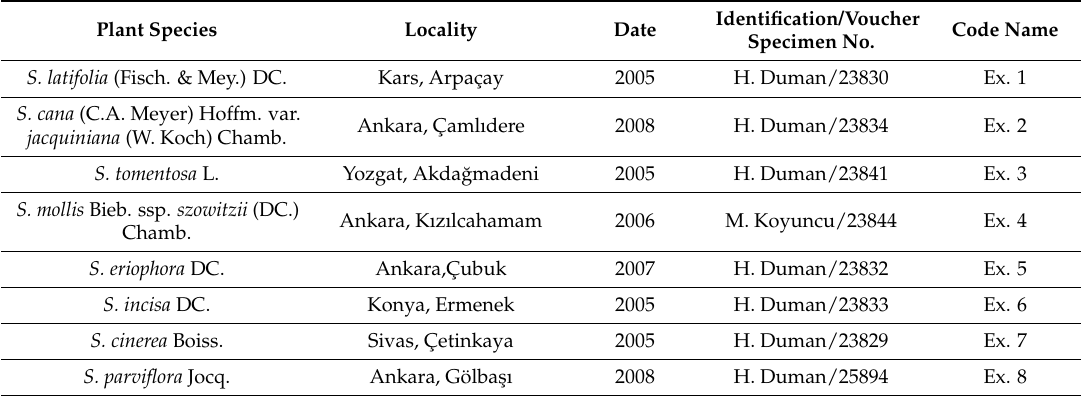
Table 1. Locality of the plant material harvest and extract coding. Plant